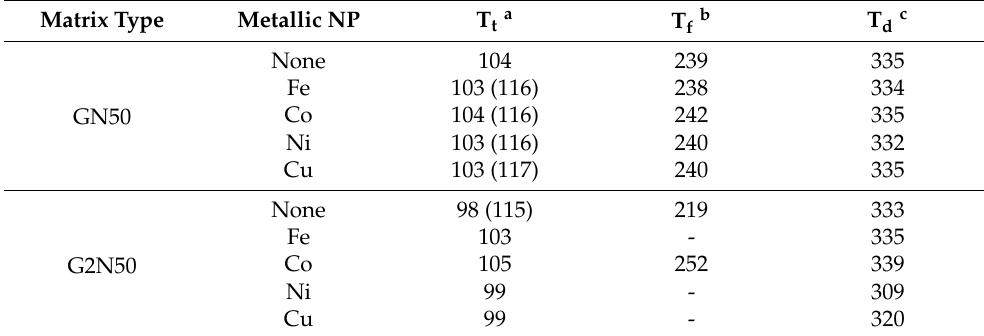
decomposition of the hydride ( ◦